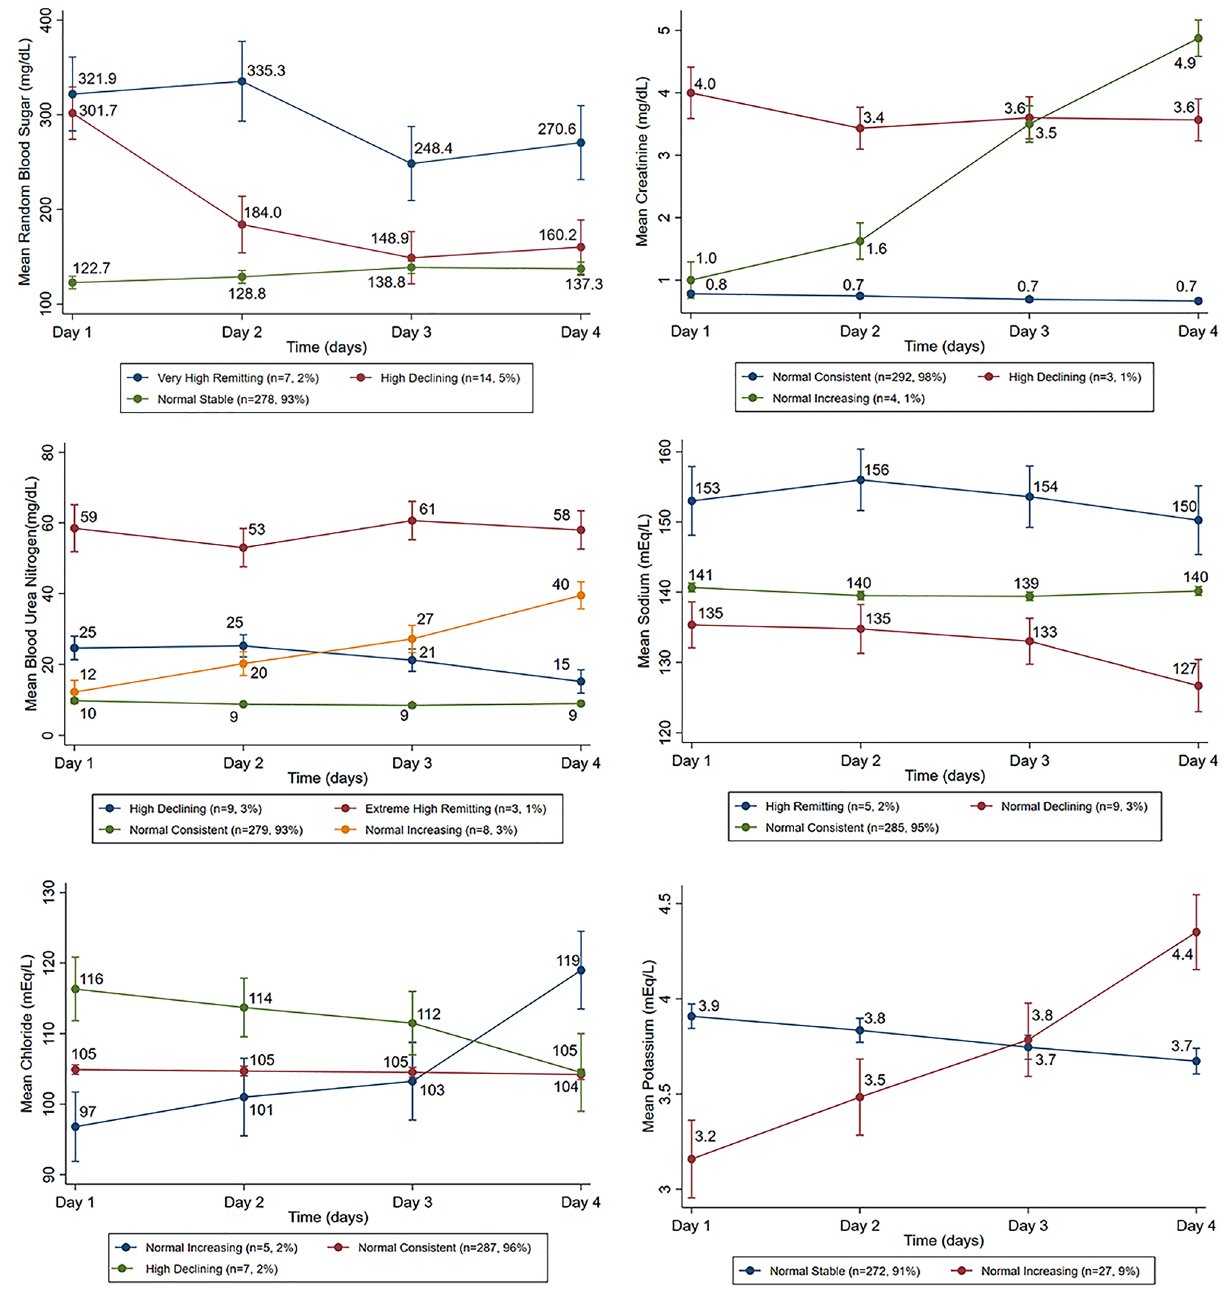
Figure 1. Trajectories of biochemical parameters from day 1 to